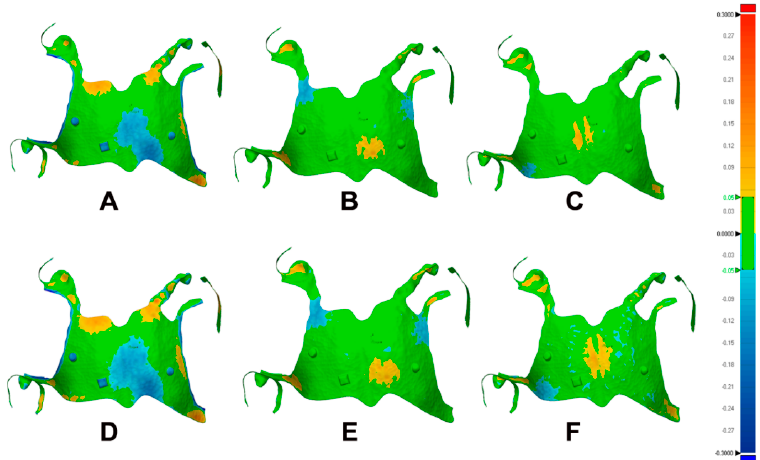
Figure 3. Sample of color maps of the three-dimensional deviations of different groups generated by the metrology software with a color-coded scale showing level of deviations. ( A – C ) represent 110, 135, and 150-degree angles with thin support structures. ( D – F ) represent same angle sequence but with thick support structures. The color maps of (110-DS) and (110-DL) groups displayed areas of negative devia- tions (bluish color) in the mid-posterior part of the major connector extended to the mid- dle area. In addition, some islands of positive deviations (yellow to orange) were seen scattered at the periphery of the frameworks, especially at the anterior borders and the minor connectors (Figure 3A,D). The color maps of (135-DS) and (135-DL) groups showed more homogenous deviations with near central positive deviation (yellow color) at the major connector and the minor connectors. Few islands of negative deviation (light blue) were seen at the periphery (Figure 3B,E). For groups (150-DS) and (150-DL), small central positive deviation in the major connector and the minor connector, and traces of negative deviation were seen (Figure 3C,F). Group (150-DS) had the most homogenous color devi- ation (more green color) among all other groups. Overall, the large diameter support groups exhibited more intense color maps than the small diameter groups, regardless of the deviations’ locations. 4. Discussion The results of the study reported that there was a significant decrease in the accuracy of frameworks manufactured at a 110-degree angle and large diameter supports. Moreo- ver, significant differences in printing time were shown among groups with different build angles regardless of their support diameters. All groups displayed significant dif- ferences in the amount of material consumed. Therefore, the first hypothesis was partially accepted. The results also showed a positive correlation between RMS and the printing time and another negative correlation between printing time and material consumed. No correlation was reported between RMS and material consumed. Accordingly, the second hypothesis could also be partially accepted. Although there was an improvement in the accuracy of the frameworks created at higher build angles and small diameter supports (Table 1) and (Figure 3A), only frame- works created at a 110-degree angle and large diameter support have significantly low accuracy (Table 1) and (Figure 3D). Building the RPD framework at a 150-degree angle and small diameter support showed the lowest RMS and so was the most accurate (Table